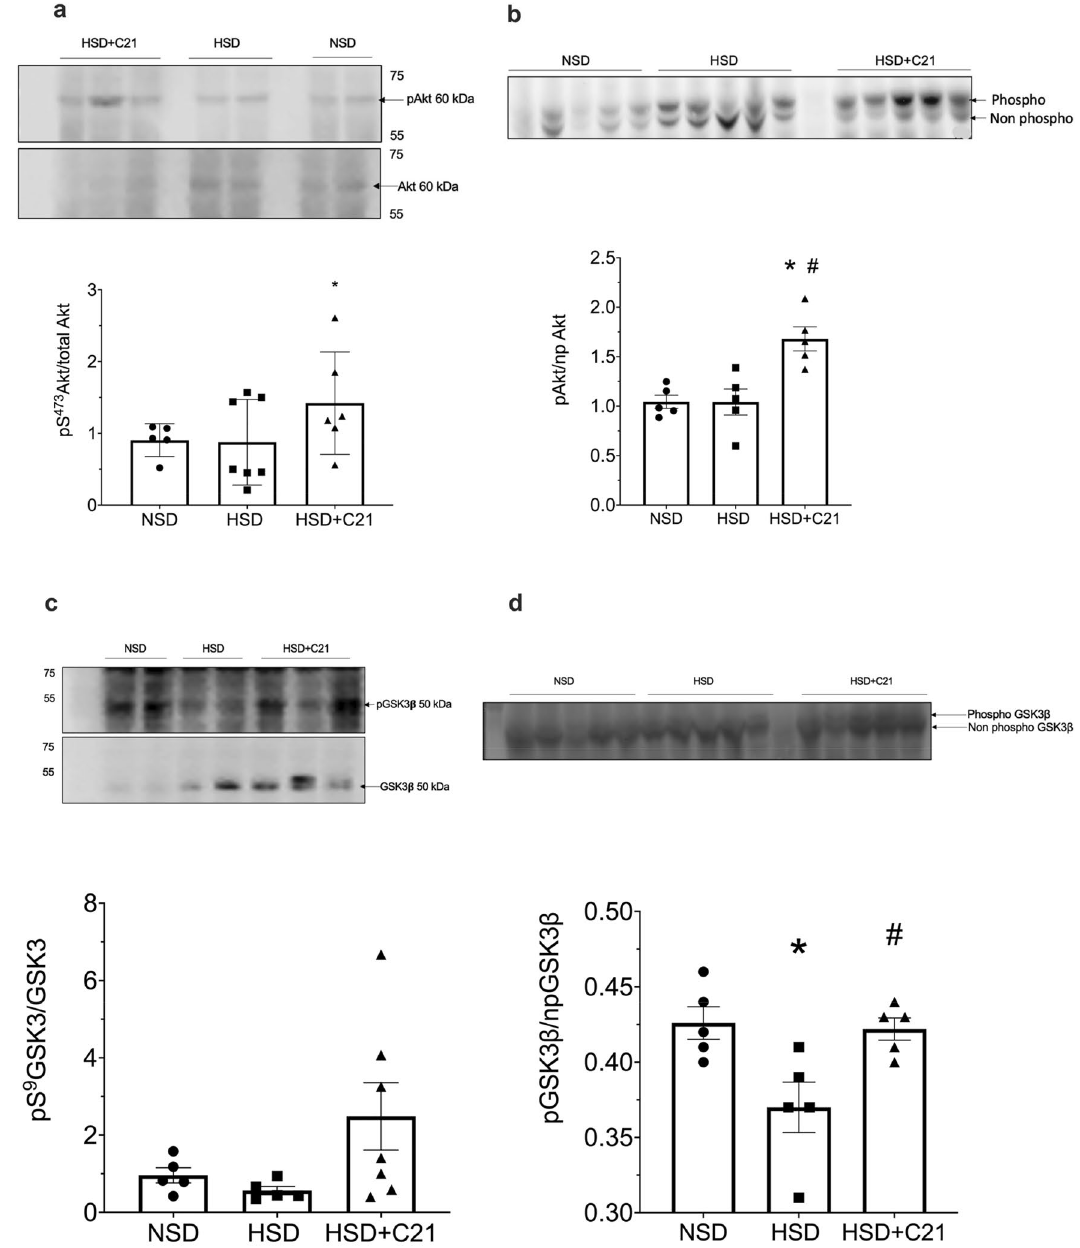
Figure 6. Representative western blot and phos-tag gel images of pAkt (6 a and 6 b ) respectively and pGSK3 β (6 c and 6 d ) respectively. Densitometry of phospho-serine bands was normalized total Akt and total GSK3 β (6 a and 6 c ) respectively, the ratio of phospho- to non-phospho-Akt and GSK3 β respectively (6 b and 6 d ). Values are represented as mean ± sem; one-way ANOVA followed by Fisher’s LSD test. * p < 0.05 versus NSD and # p < 0.05 versus